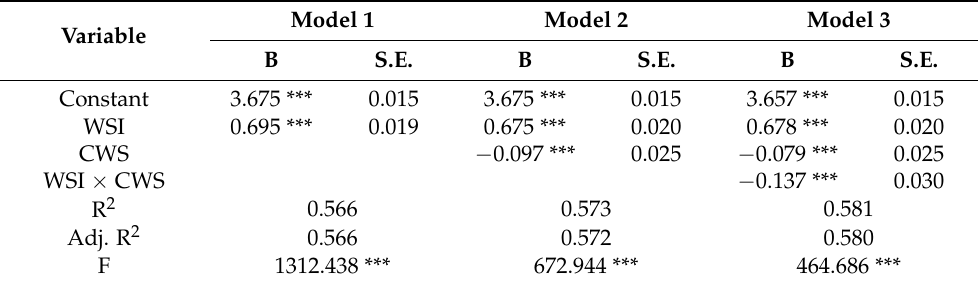
Table 5. Results of the test on the moderating effect of waste separation cost.